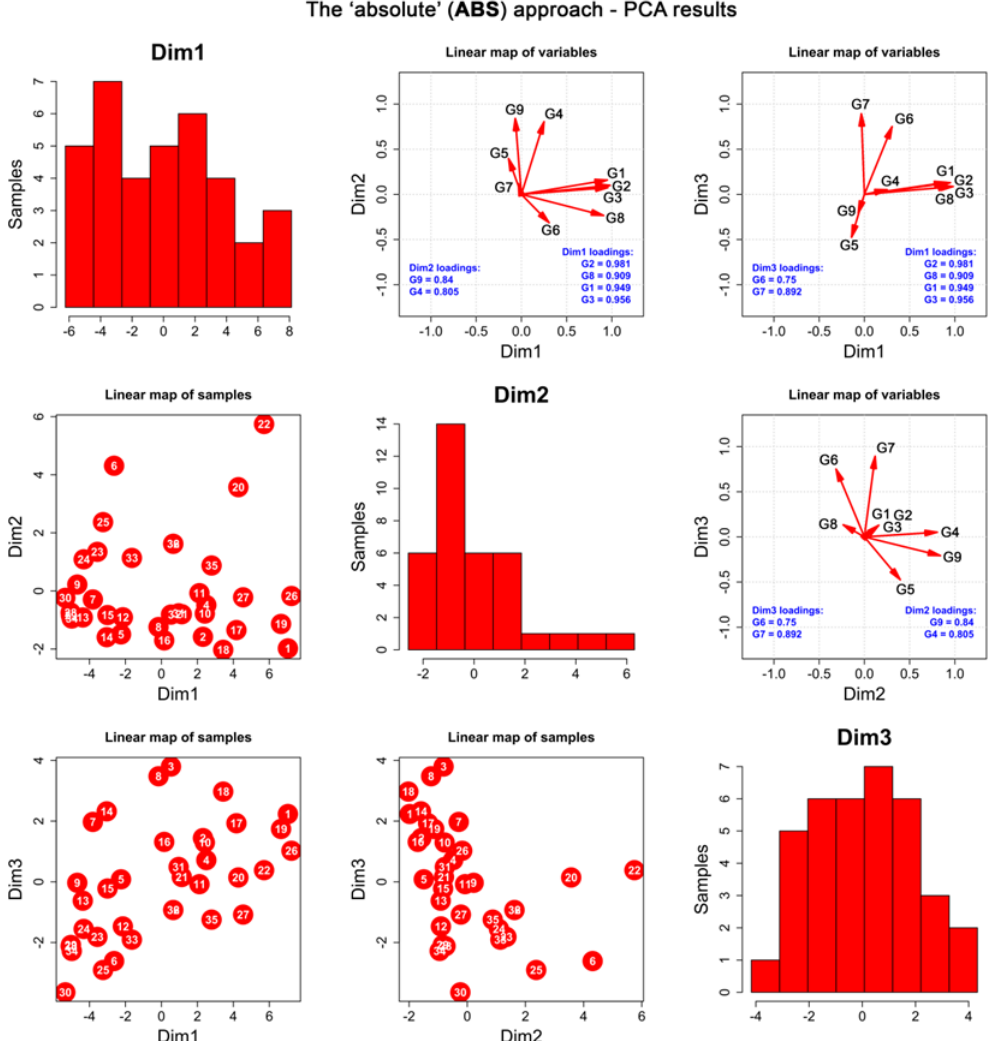
Figure 2. PCA performed for the ABS dataset. Diagonal: histograms of the first three resulting PCs subjected to VARIMAX rotation (henceforth known as dimensions, Dim ). Lower triangle: linear maps of samples in the space of the first three dimensions. Upper triangle: linear maps of original variables (compounds) in the space of the first three dimensions. The numbers correspond to the numbering presented in the Section 3.1.